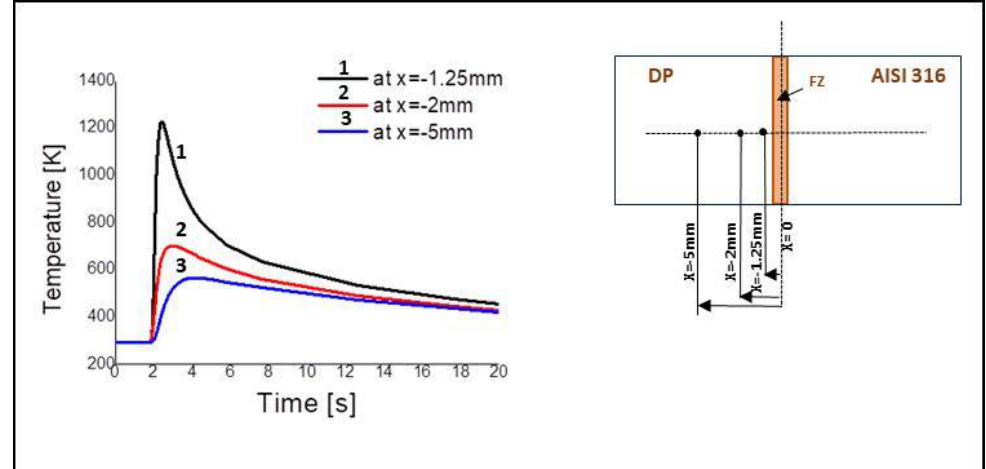
Figure 9. Thermal cycle of DP steels along the x direction: x = −1.25 mm, x = −2 mm, x = −5 mm.